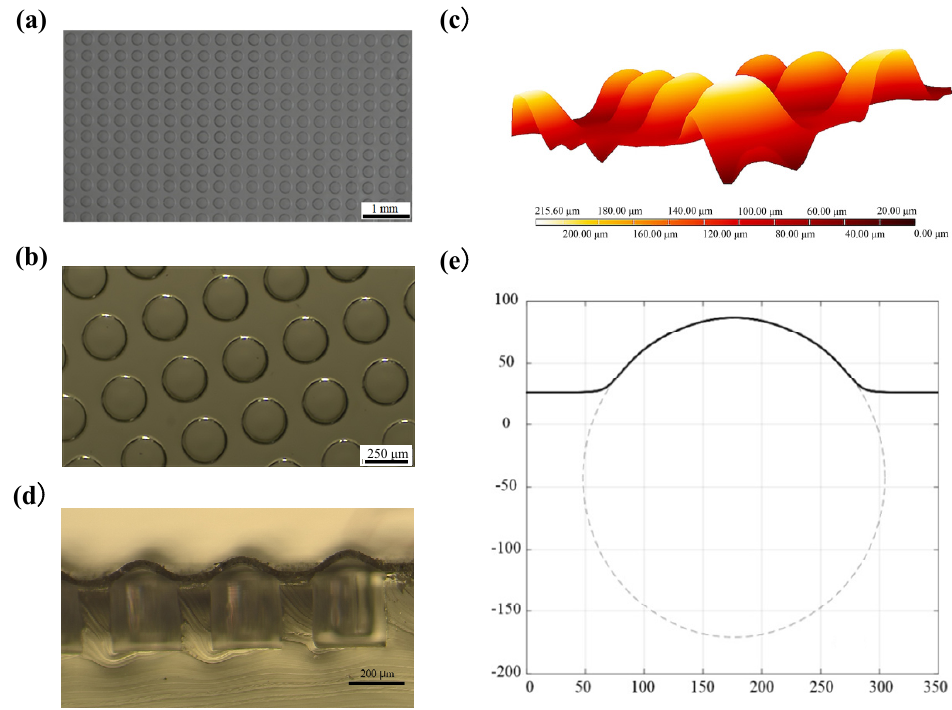
Figure 3. ( a ) Optical microscope image of the microstructures (magnification: 50×), illustrating the order and shape uniformity of the array structure; ( b ) Optical microscope image of the microstructures (magnification: 200×), displaying the two-dimensional (2D) morphology of the microstructures; ( c ) three-dimensional (3D) surface profiles of the fabricated film microstructures measured by using a laser scanning confocal microscope; ( d ) 2D cross-sectional view of the fabricated film microstructures; ( e ) The 2D surface profile of a typical curved film microstructure (solid line) and the fitted circle (dashed line).